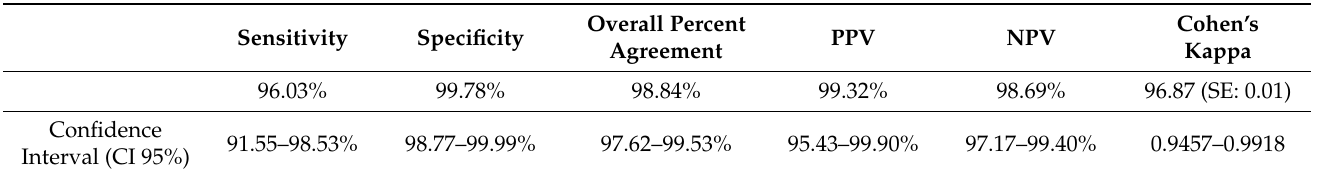
Table 2. GeneFinder COVID-19 Ag Plus Rapid Test performance, compared to RT-PCR standard assay (NAAT).